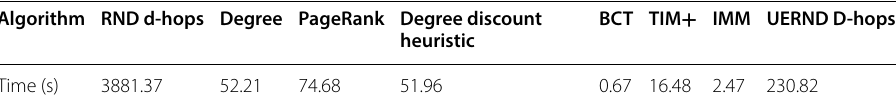
Table 5 Running time of our algorithm compared with existing work on netphy data for K 50 under the IC model = Algorithm RND d‑hops Degree PageRank Degree discount